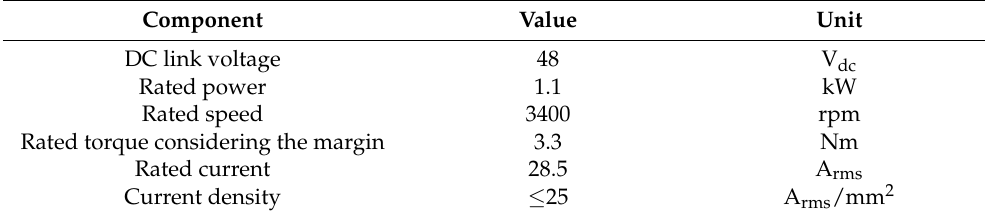
Table 2. Rated condition of the motor for the collaborative